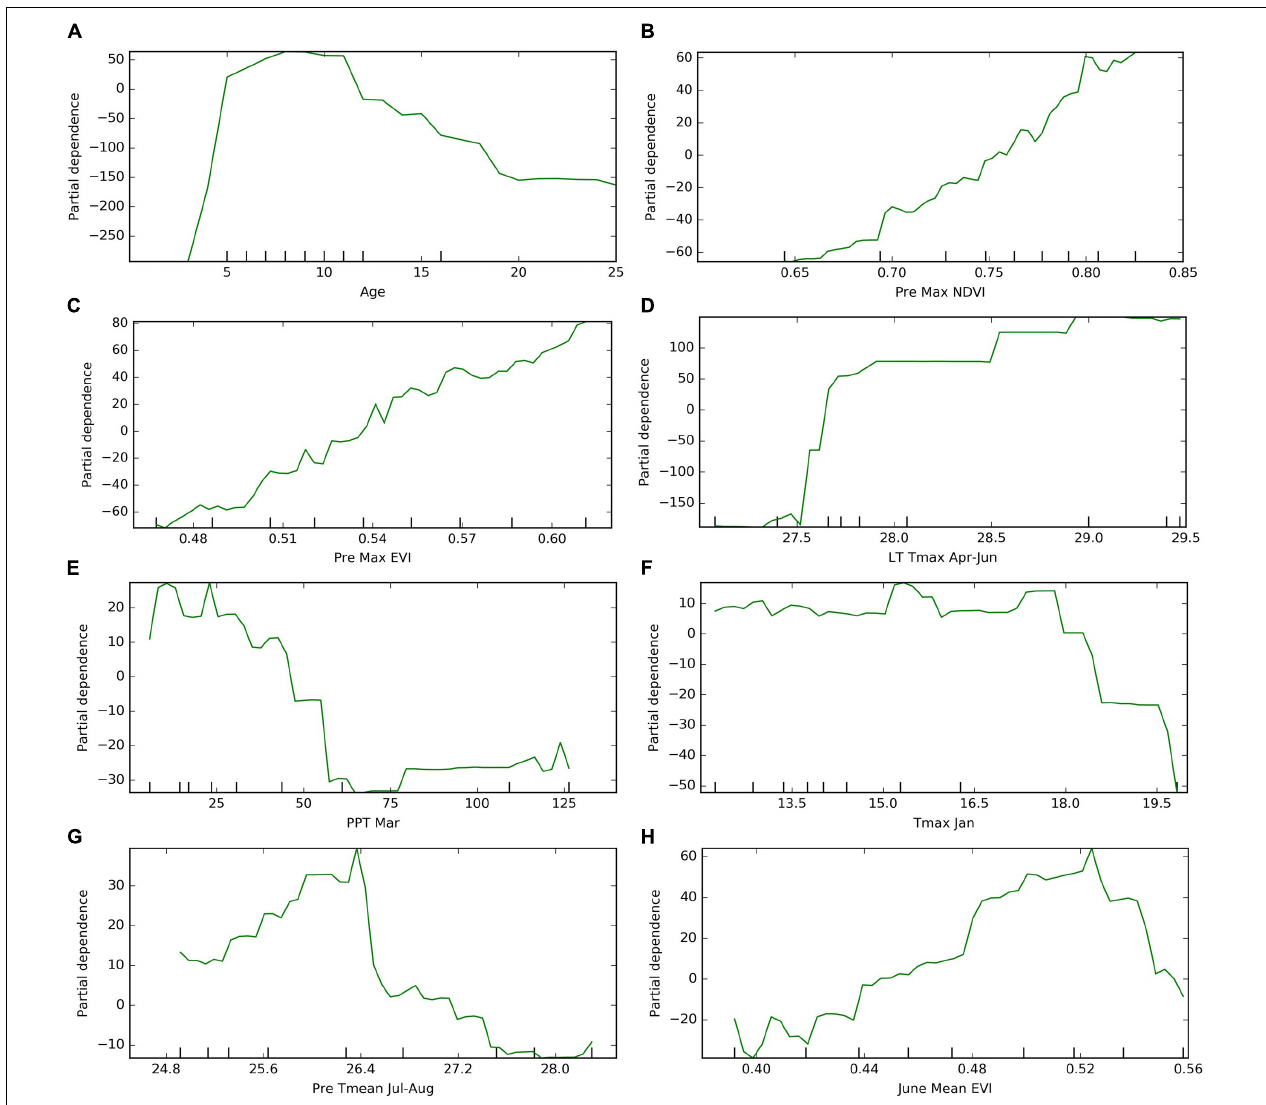
FIGURE 8 | Partial dependence of target year’s yield on (A) age, (B) previous year maximum NDVI; (C) previous year maximum EVI; (D) long term maximum temperature in April–June; (E) target year March precipitation; (F) target year’s January maximum temperature; (G) previous year summer temperature; (H) target year June mean EVI. ∗ The results were based on “Mid-NoYld-NoCul”